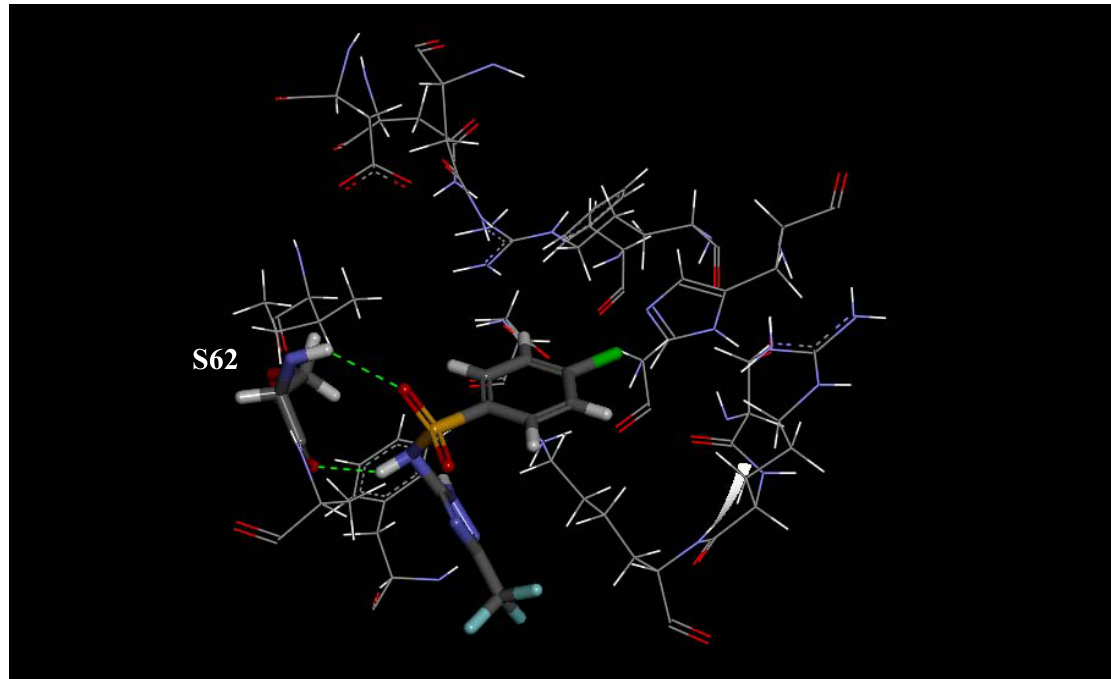
Figure 4. Docking of 14 into P. falciparum